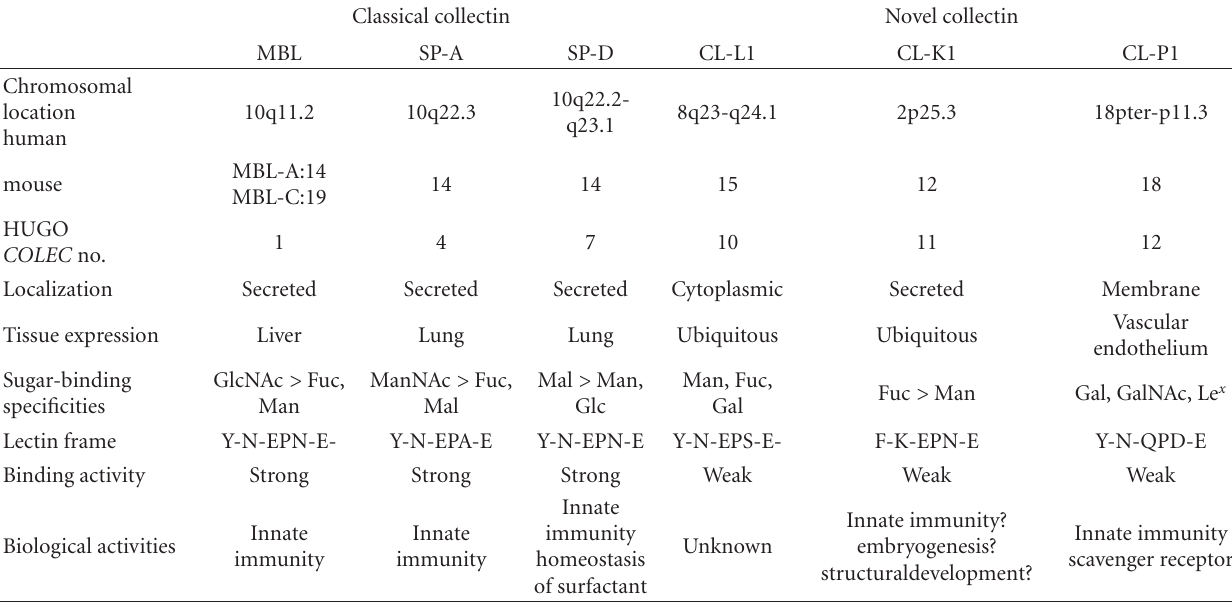
Figure 2: A schematic of the gene evolution of collectin and complement 1q (C1q). The extraordinary numbers of the two genes in amphioxus show that this life form has undergone enormous evolutionary changes since its emergence. Table 1: Characteristics of classical collectin and novel